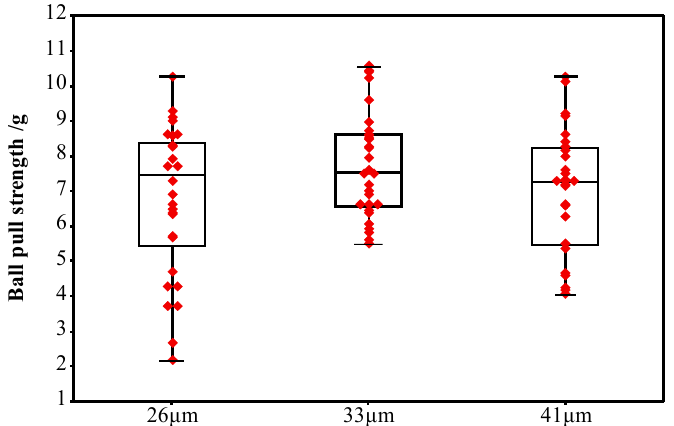
Figure 6. The pull strength of the ball bonded points with IHDs of 26, 33 and 41 μ m respectively. When the IHD of the capillary is 26 µ m, the gap between the inner hole wall of the capillary and the alloy wire is 0.5 µ m. The friction force increases between alloy wire and inner hole wall during the bonding process, which causes the ball bonding neck to shift, and the deformation rate increases, and then the pull strength value of the ball bonded point decreases. The neck of the ball bonded point is fractured due to the large deformation rate when the friction force is further increased, as shown in Figure 5d, even the ramic capillary is 41 μ m, the gap between the inner hole wall of the ceramic capillary and the alloy wire increases due to the large IHD, resulting in a low coaxiality between the alloy wire and the inner hole of the ceramic capillary and the neck of the ball bonded point is not symmetrical due to the alloy wire is not fixed enough during bonding. Fi-